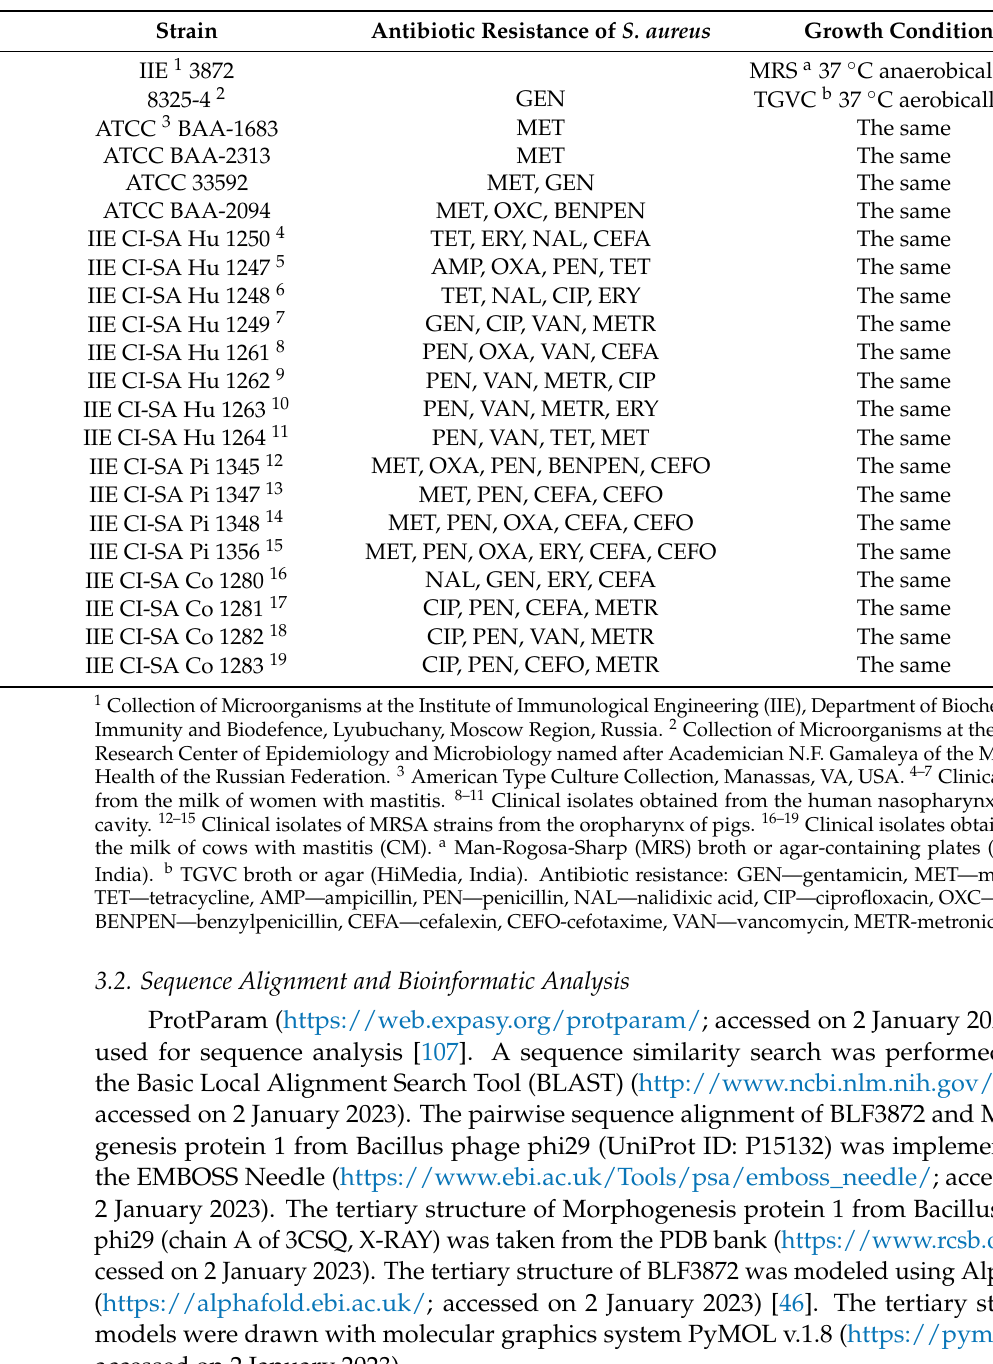
Table 10. Microorganisms used in this